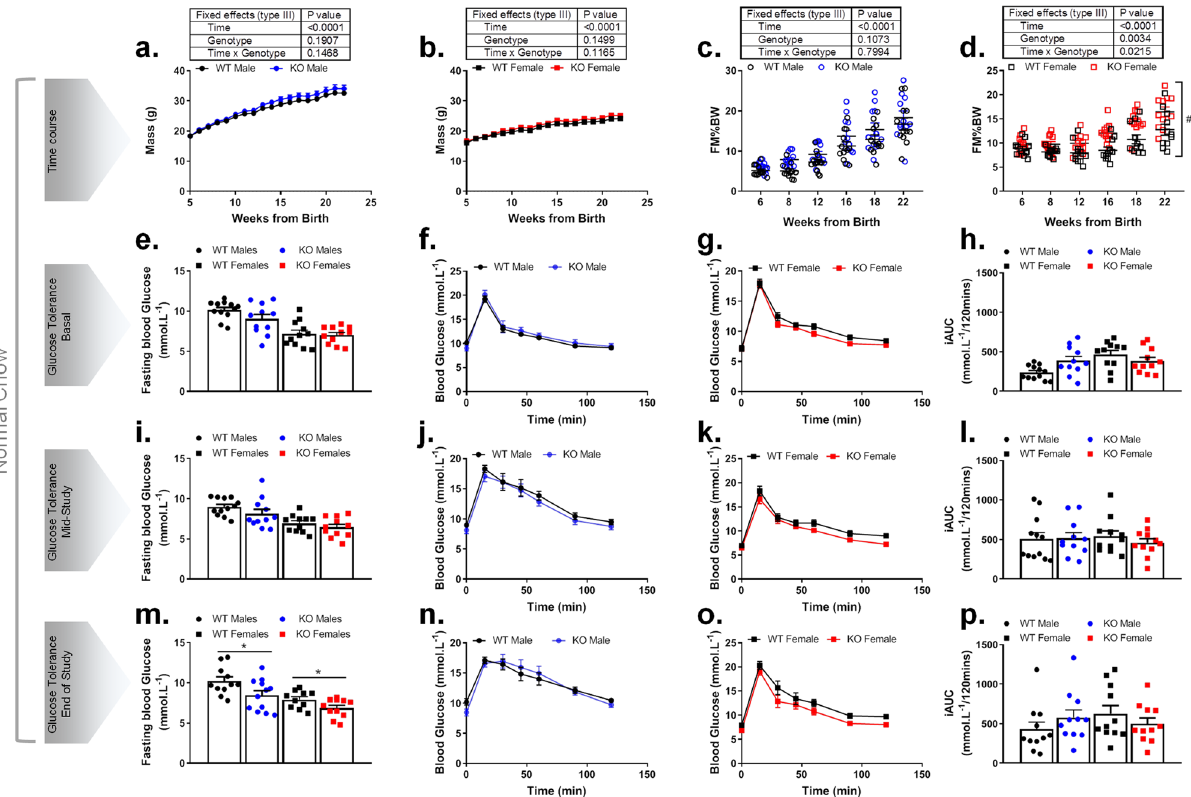
Fig. 2 Trim28 adi-KO increases adiposity but preserves glucose homeostasis in male and female mice fed a chow diet. Total body weight of male ( a ) and female ( b ) Trim28 WT and adi-KO (KO) mice over 22-week study period on chow diet. Body composition including body mass and fat mass presented as percent body weight (BW) for ( c ) male mice and ( d ) female mice from 6 weeks of age. Fasting blood glucose and oral glucose tolerance test in male and female mice with corresponding incremental area under the curve (iAUC) at 6 weeks of age ( e – h ; basal), 10 weeks of age ( i – l ; mid-study), and 22 weeks of age ( m – p ; end of study). All data are presented as mean ± SEM, female mice n = 11 WT and n = 11 KO, and male mice n = 12 WT and n = 11 KO. All data were analyzed using two-way ANOVA where * p < 0.05, or repeated measures mixed-effects model where # p < 0.05 for time × genotype